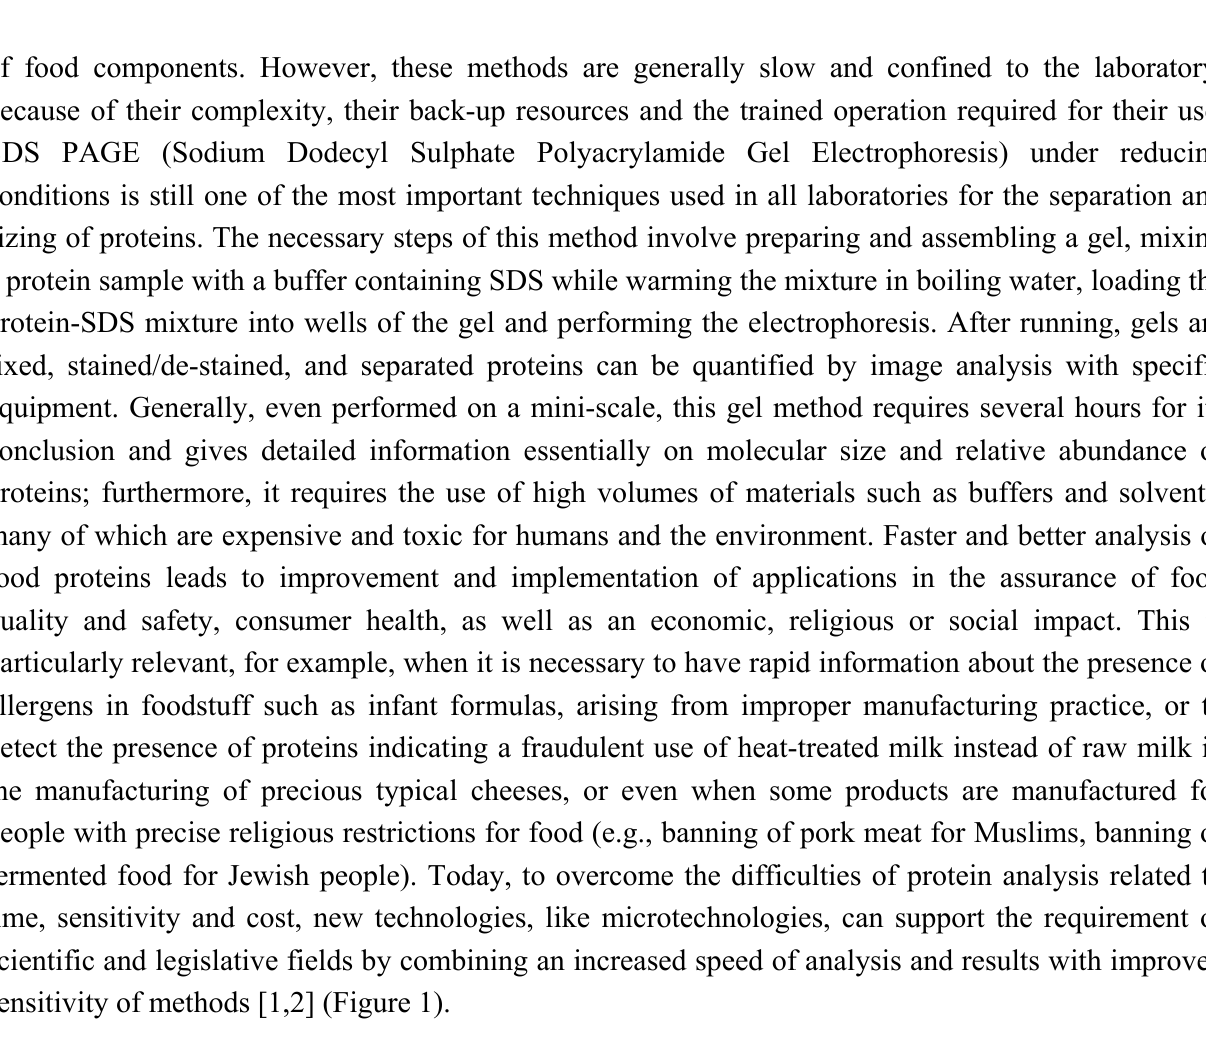
Figure 1. Some of the most important requisites for the modern analytical techniques.